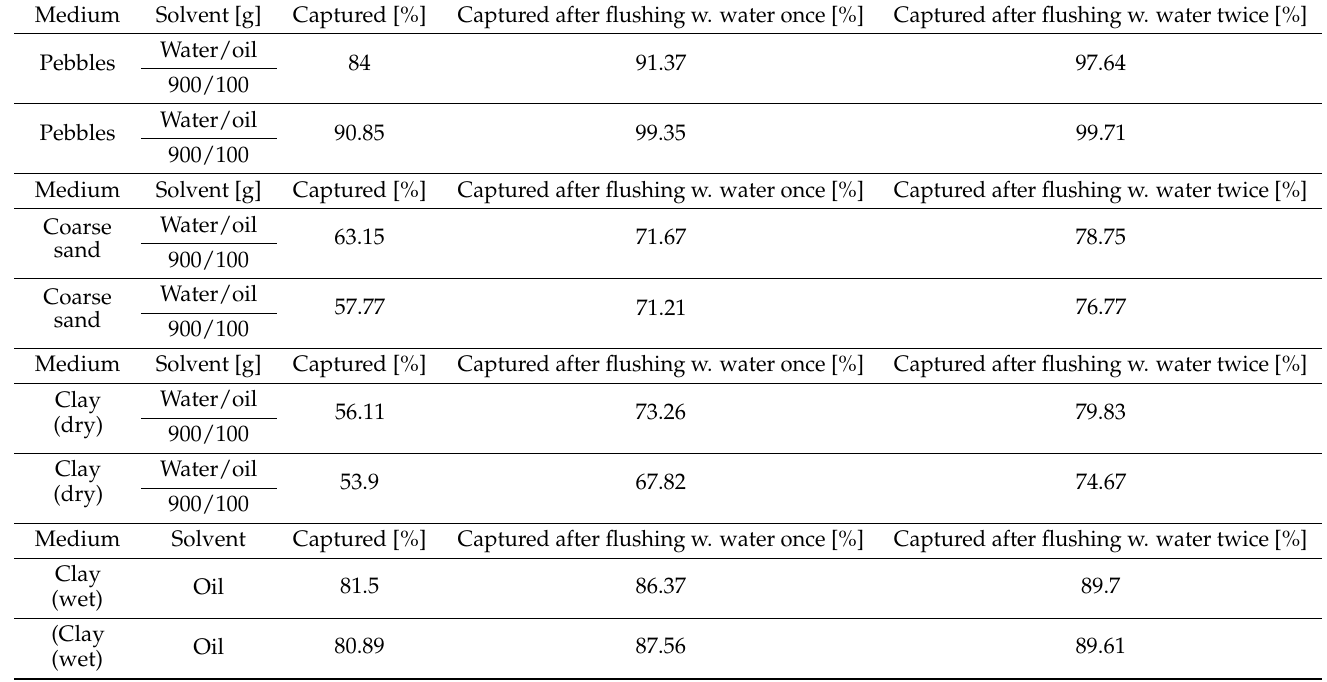
Table 5. How much plant oil stays in the ground after flushing with the